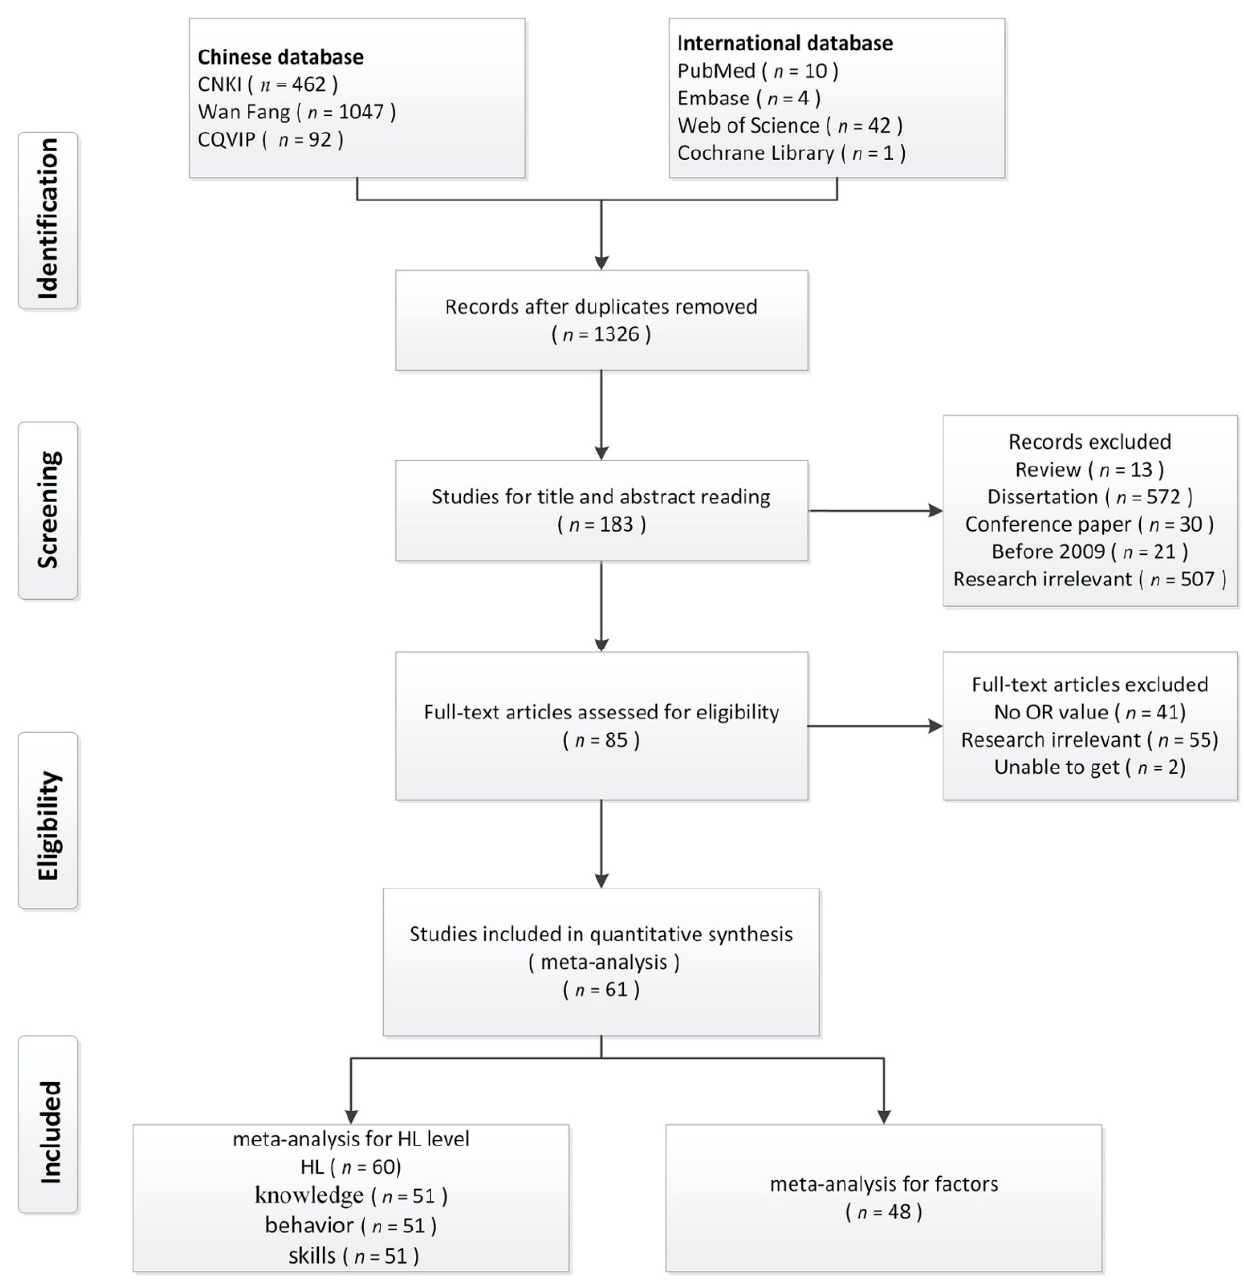
Figure 1. Selection process of included studies.